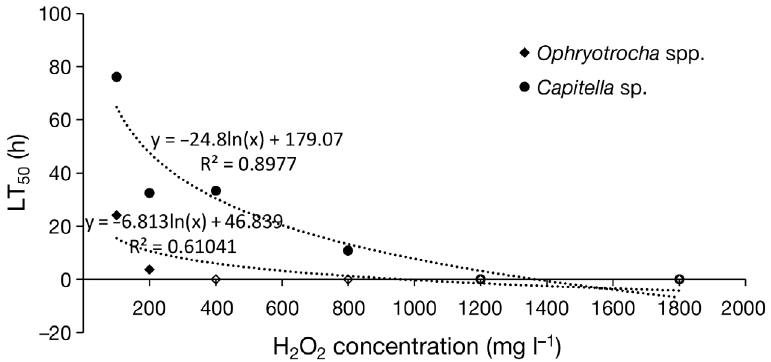
Fig. 3. Lethal time (LT 50 , h) of 2 polychaete species (Capitella sp. and Oph - ryo trocha spp.) exposed to different hydrogen peroxide (H 2 O 2 ) concentra- tions. The markers without filling mean the LT 50 is less than 1 h. The equa- tions stem from the results of curve estimation analysis of the